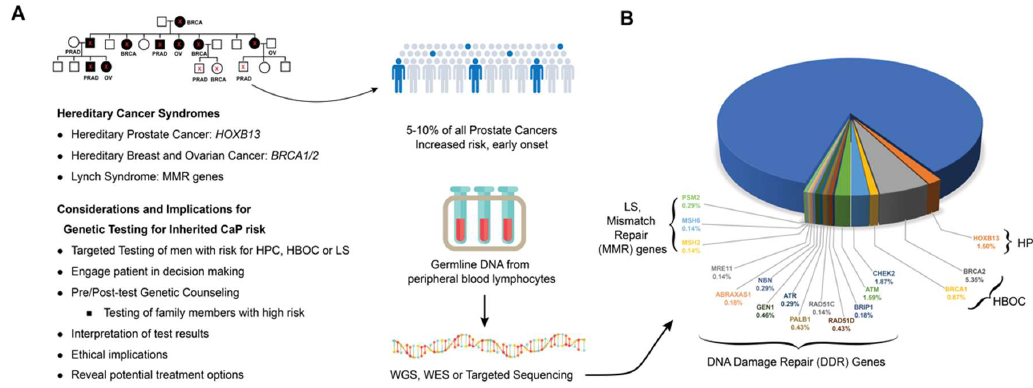
Figure 2. Hereditary cancer syndromes and prostate cancer. Men from families with hereditary cancer syndromes, including Hereditary Prostate Cancer (HPC), Hereditary Breast and Ovarian Cancer (HBOC) and Lynch Syndrome (LS), which are associated with defects in HOXB13 , BRCA1/2 and DNA Mismatch Repair genes, respectively, may benefit from genetic testing ( A ). Frequency of pathogenic germline alterations in DDR genes [30,100,101] and in genes associated with hereditary cancer syndromes (HPC [29,102], HBOC [103], and LS [104–106]) detected in metastatic prostate cancers ( B